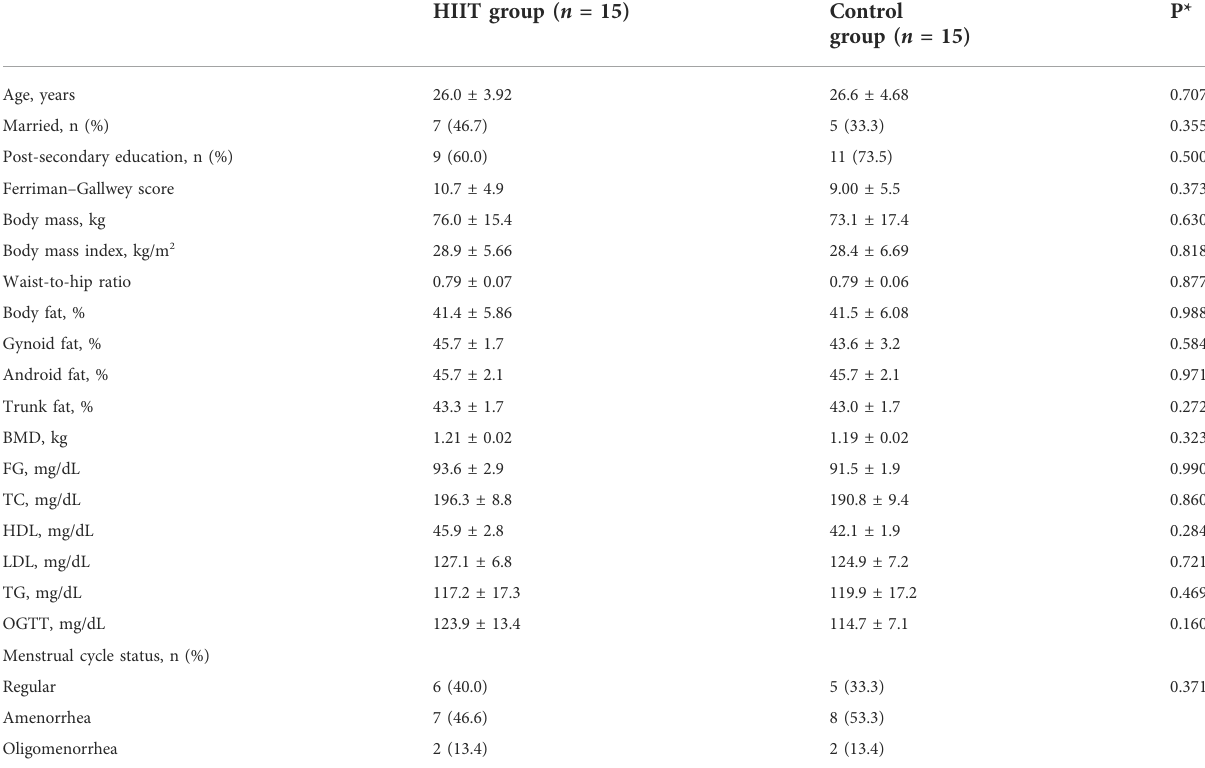
TABLE 2 Baseline characteristics of the HIIT and control